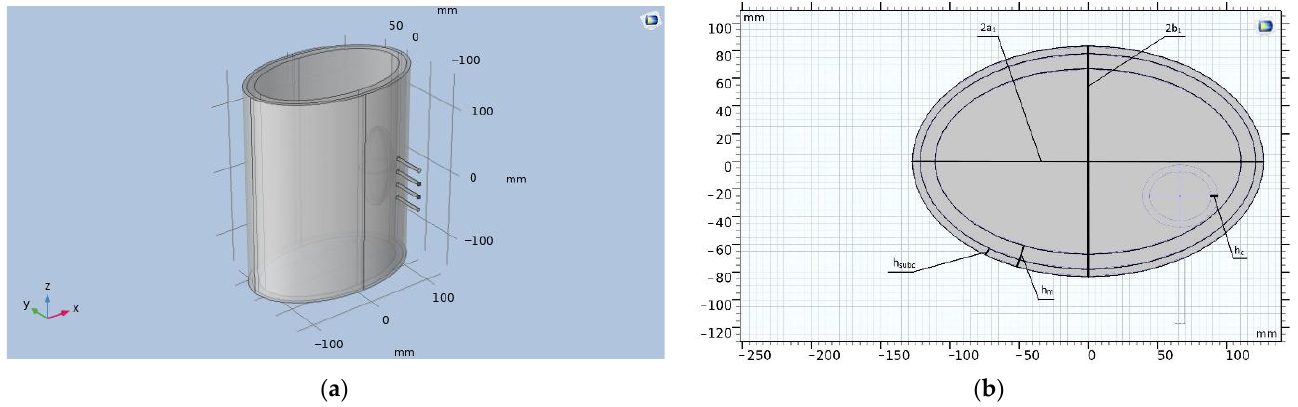
Figure 3. ( a ) Model of the perirenal space in the COMSOL Multiphysics 5.5 software; ( b ) Geometric parameters of the model (cross section), where 2a1 — is the major axis of the ellipse (cross section of the trunk), 2b1 — is the minor axis of the ellipse (cross section of the trunk), hsubc — is the thickness of the subcutaneous fat layer, hm — thickness of the muscle layer, hc — thickness of the renal cortex. In this model, the kidney is represented by a two-layer ellipse. These layers mimic the renal cortex and medulla. The kidney is located in the fibrous layer, presented in the form of a cylinder with major and minor axes (2a 1 − 2h m ) and (2b 1 − 2h m ), respectively. The electrodes are modeled as cylinders equidistant from each other with a base diameter of 3 mm. Table 1 shows the geometrical dimensions of the designed model obtained from MRI-images. Table 1. The geometrical parameters of the designed model.